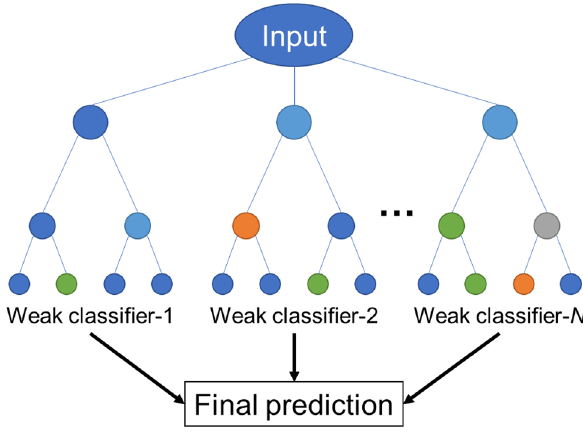
Figure 4. The basis of RF classification.